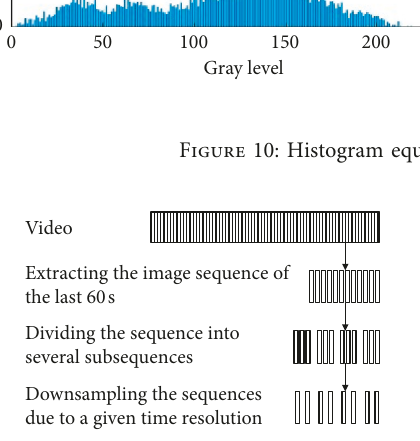
Figure 11: Flowchart for enlarging the amount of training data.